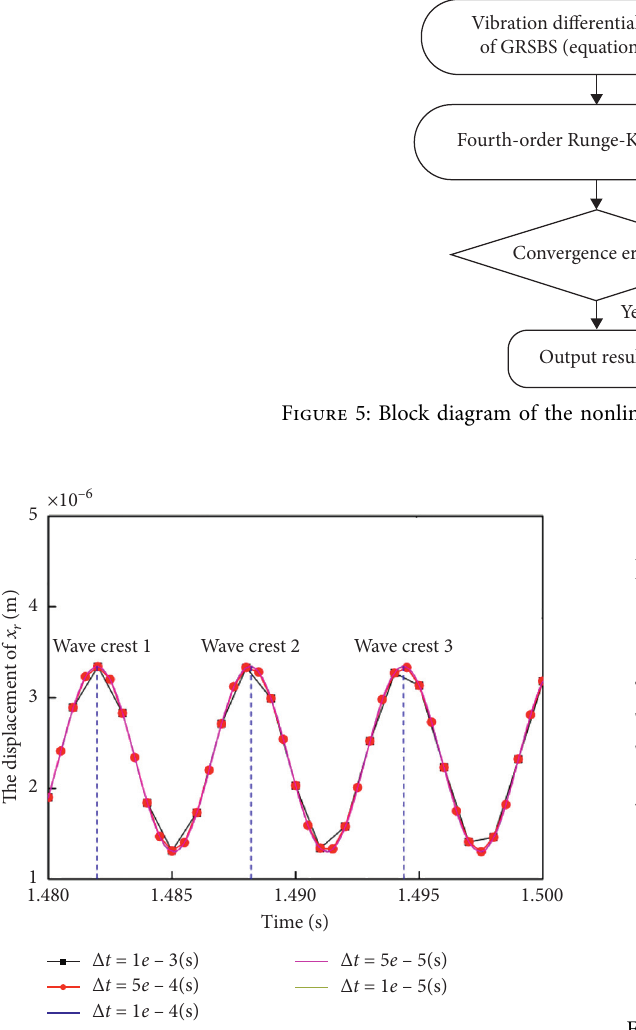
r with different calculation